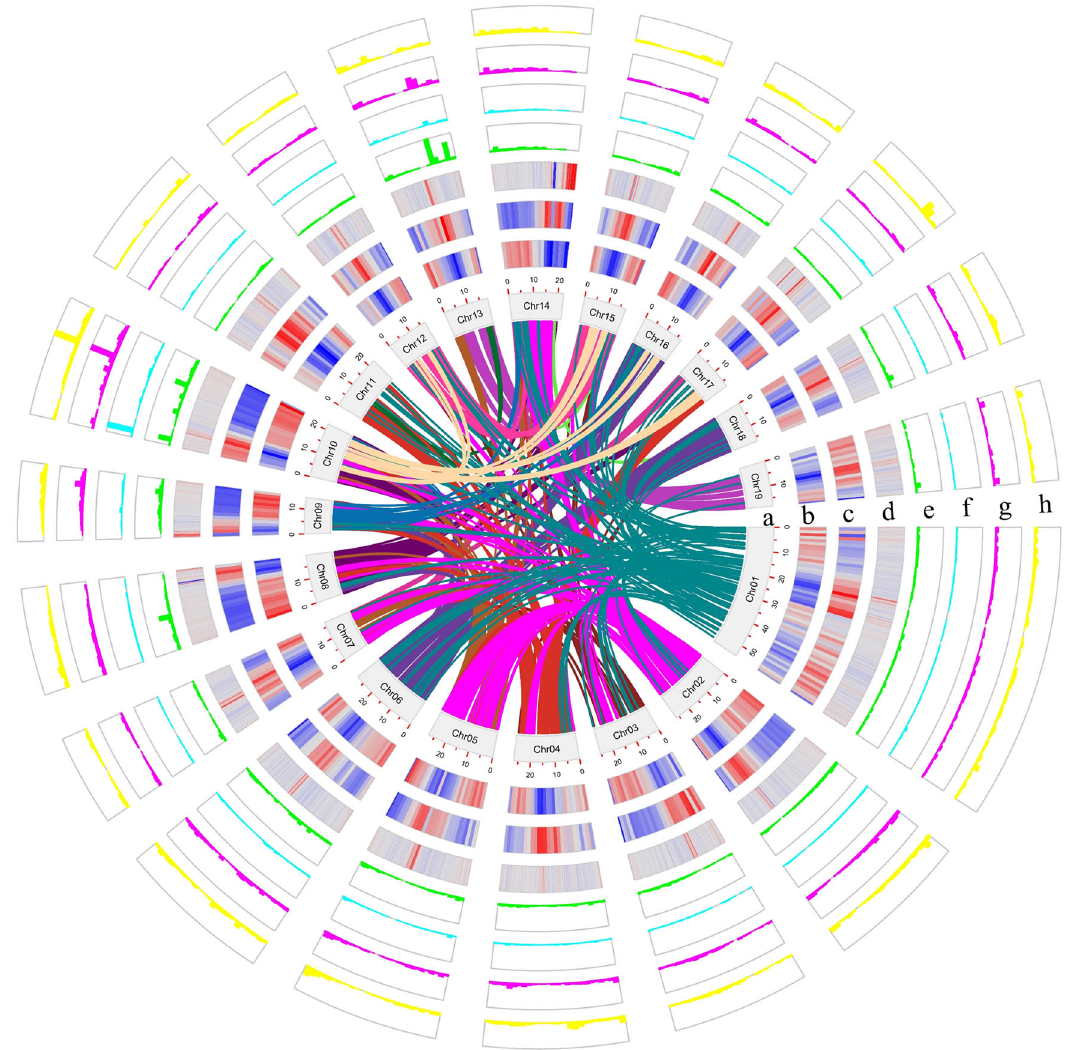
Fig. 1 Overview of Populus wilsonii Genome. Elements are arranged in the following scheme (from inner to outer). a The 19 chromosomal pseudomolecules, units on the circumference are mega base values of pseudomolecules, ( b ) gene density, ( c ) repeat density, ( d ) GC content and gene expression levels in root ( e ), phloem ( f ), xylem ( g ) and leaf ( h ) are shown in 500 kb windows sliding 50 kb. Central colored lines represent syntenic links between the